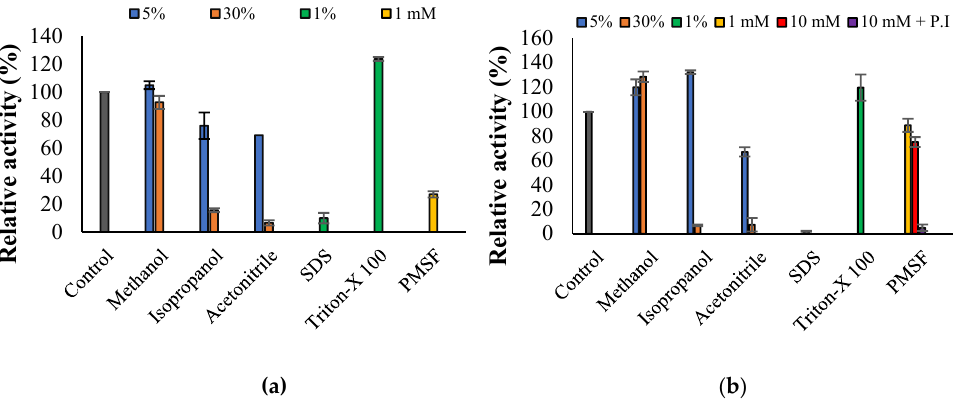
Figure 9. Effects of organic solvents, detergents, and PMSF on enzyme activities of Est2L ( a ) and Est4L ( b ). P.I., preincubated for 30 min.